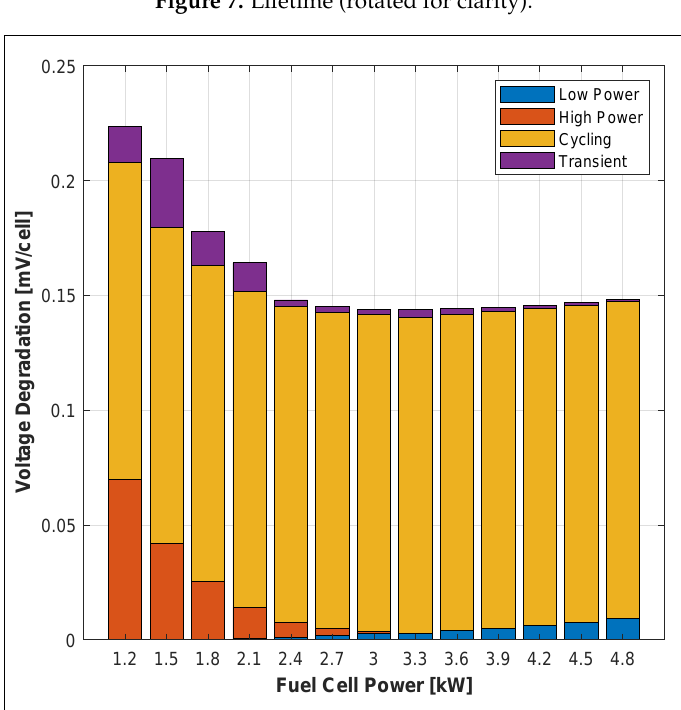
Figure 7. Lifetime (rotated for clarity).